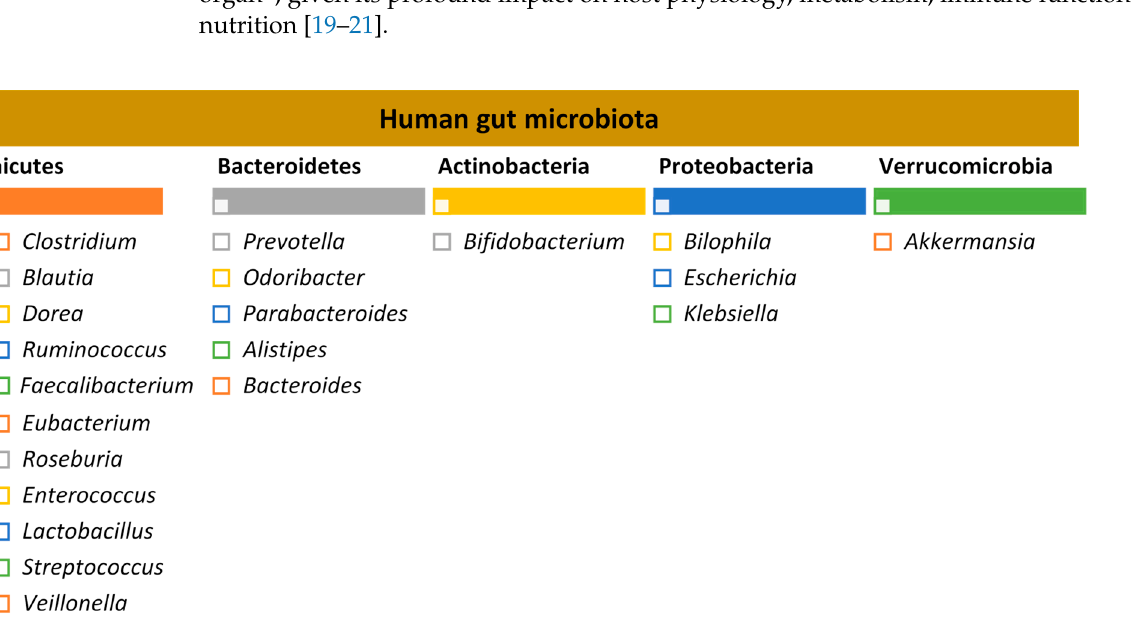
Figure 1. Human gut microbiota: the five major bacterial phyla and their predominant genera, according to the study by Qin et al. 2015 [22,23].